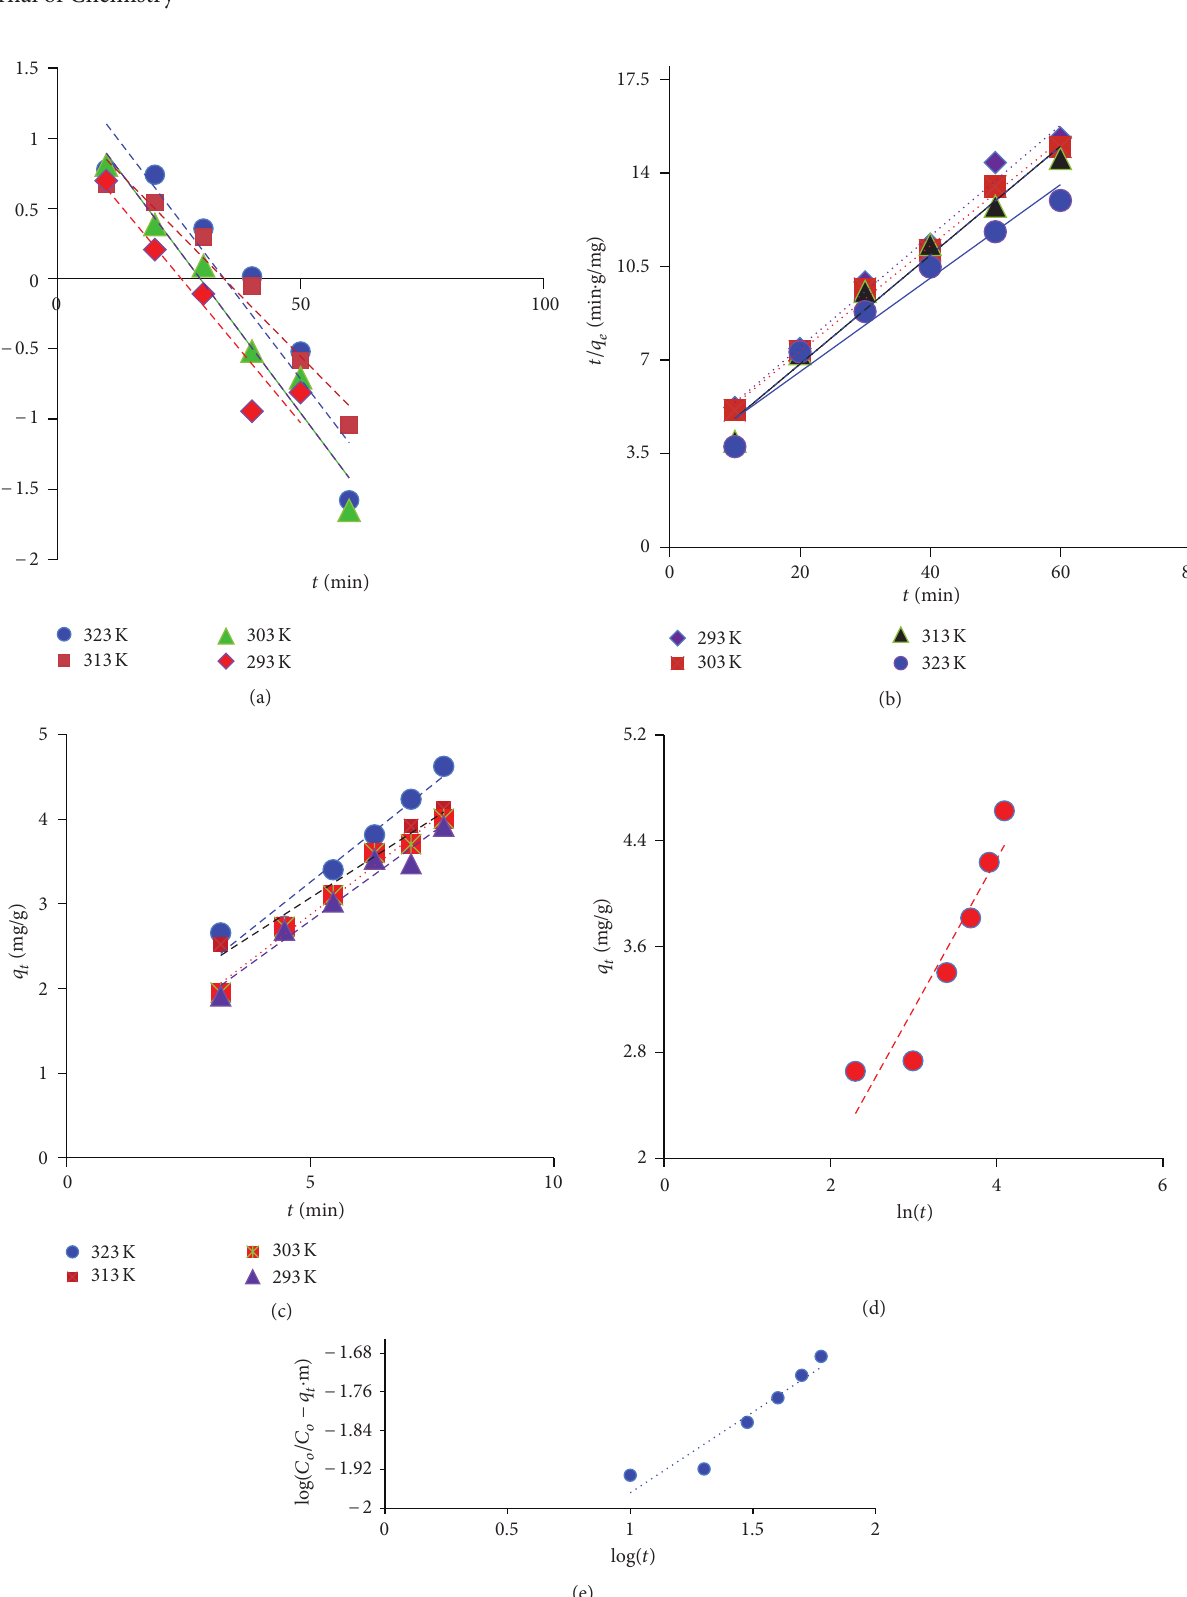
F 2: (a) �seudo��rst�order kinetics model, (b) pseudo�second�order kinetics model, (c) intra�particle di�usion kinetic model, (d) Elovich kinetic model, and (e) Bangham kinetic model for sorption of Co(II) ions on SB: pH, 6.0; concentration, 50mg/L; adsorbent dose,